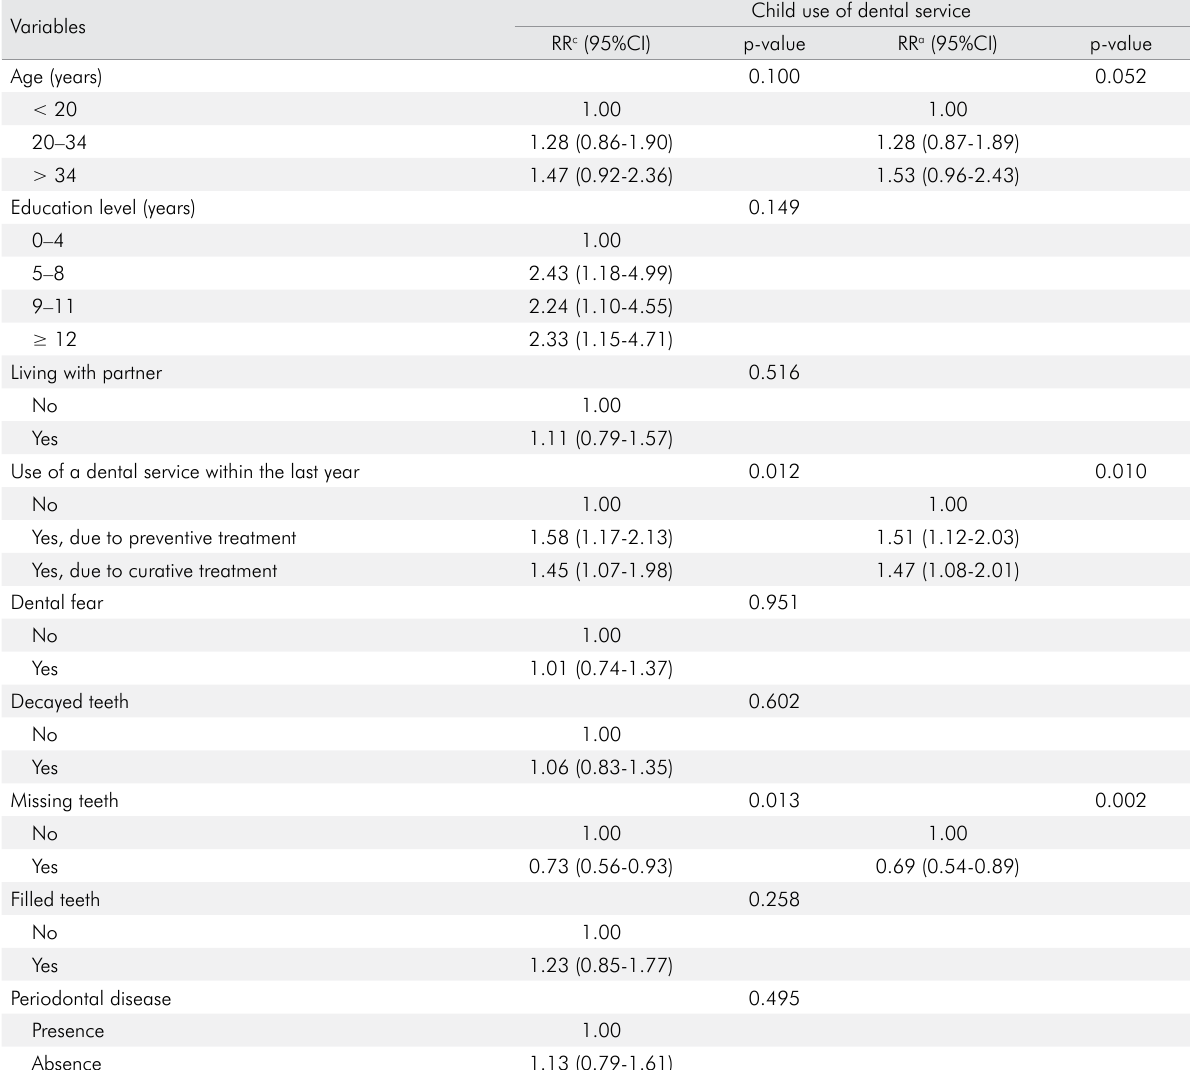
Table 2. Crude and adjusted analyses of maternal variables and child use of dental services until 12 months of age in a birth cohort in the city of Pelotas, RS, Brazil, 2020 (n = 2,387).